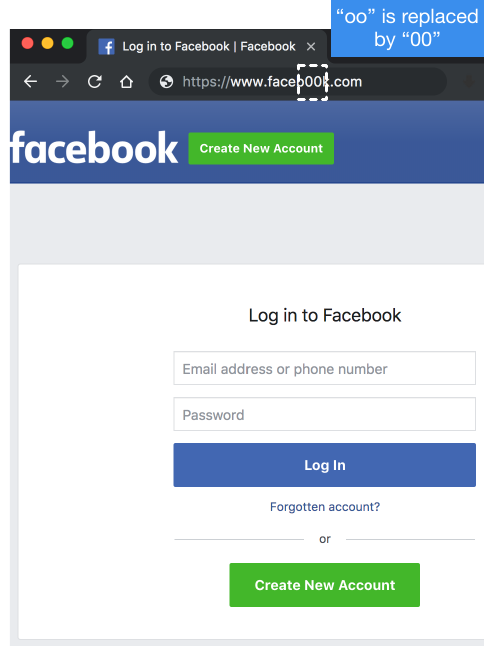
Figure 1. One example of a phishing website imitating the popular website